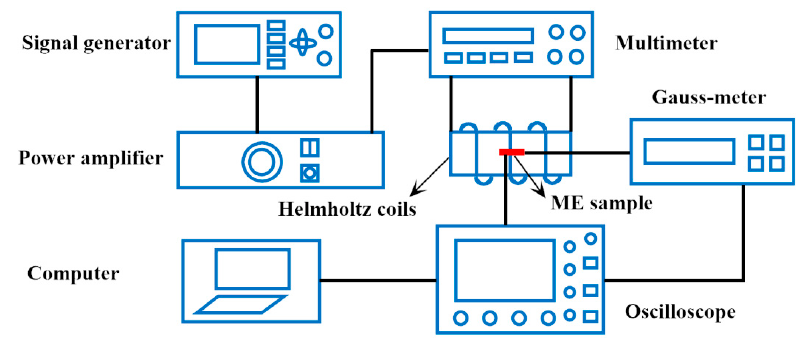
Figure 4. Schematic diagram of ME comprehensive testing system.